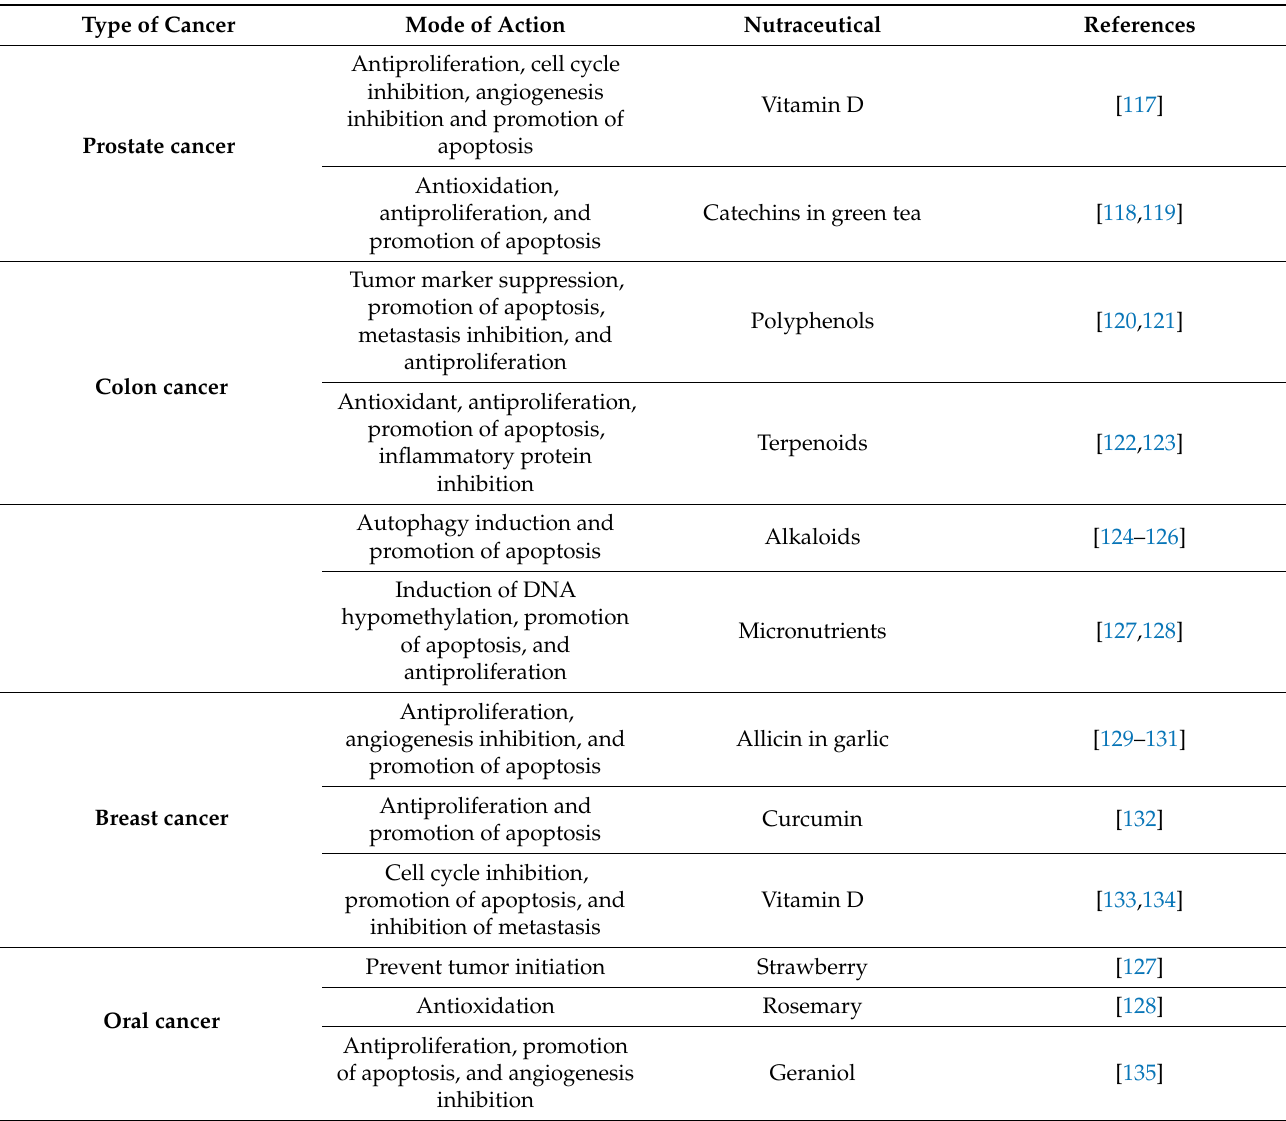
Table 2. Selected anti-cancer modes of action classified based on cancer type and nutraceutical. Type of